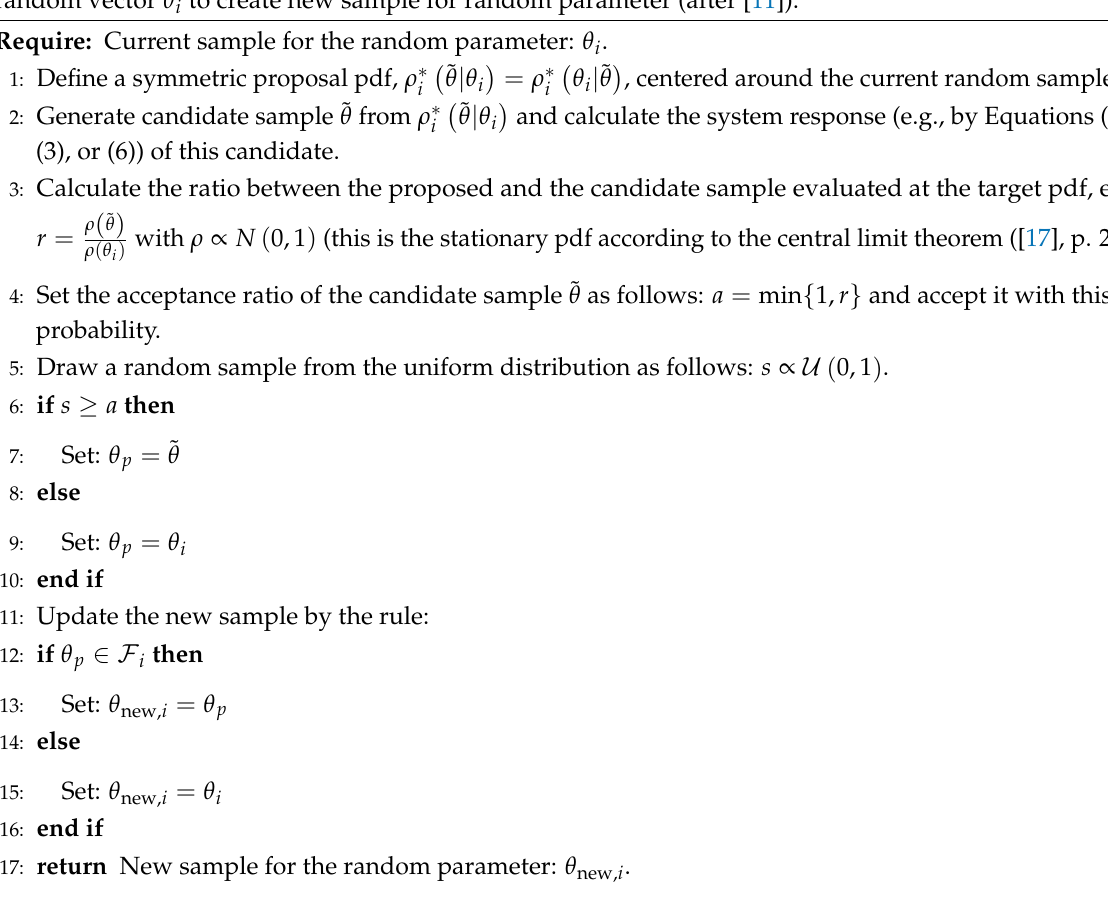
Algorithm 2 Modified Metropolis–Hastings algorithm for subset simulation for each component of the random vector θ i to create new sample for random parameter (after